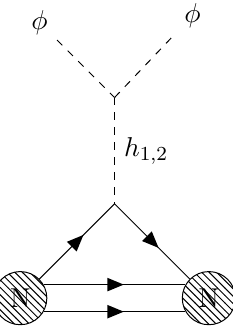
Figure 23 . Feynman diagrams for the direct detection of wimp DM φ